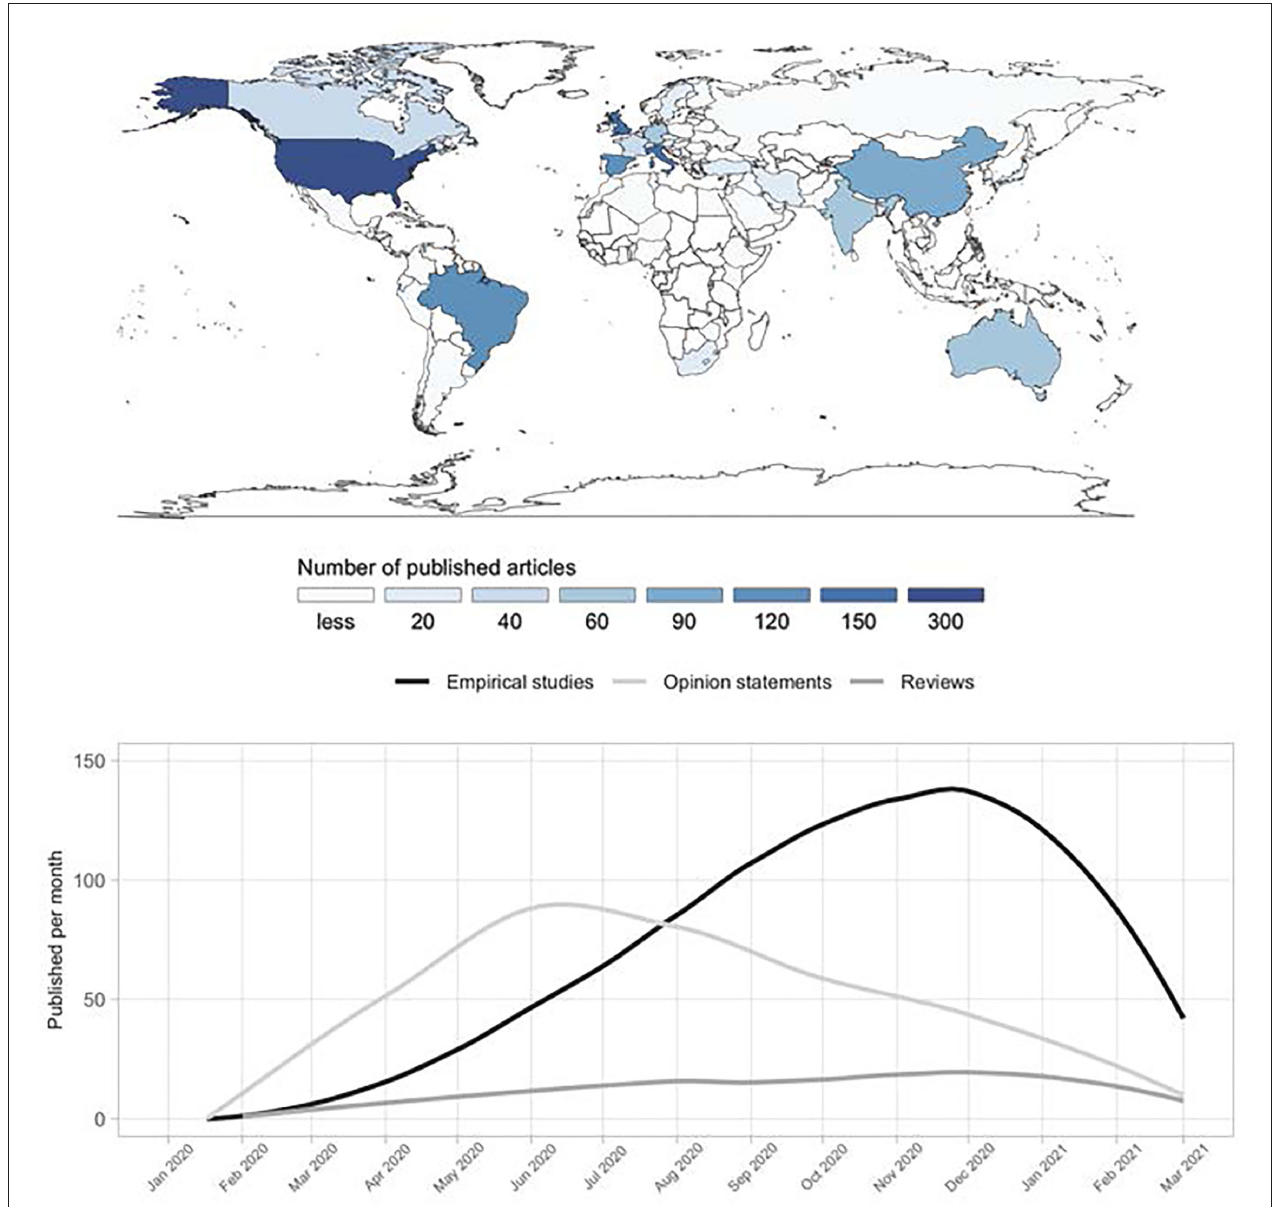
FIGURE 3 | Timing of publications and contributions from countries. Number of published articles per month (top), and publication types and dates of all articles ( N = 1,903) published on PA, sport, and exercise in the first 365 days of COVID-19 pandemic as declared by WHO